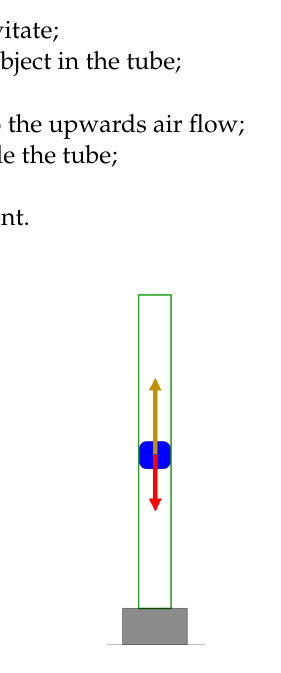
Figure A1. Balance of forces acting over the levitating